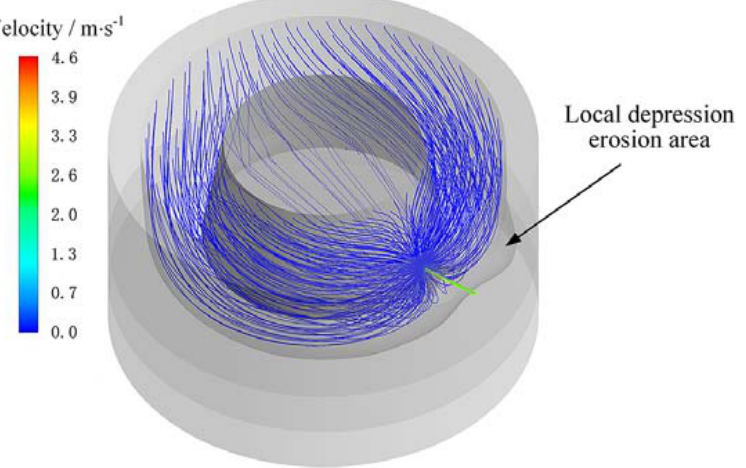
Figure 6. The hot iron streamline of the normal production model.